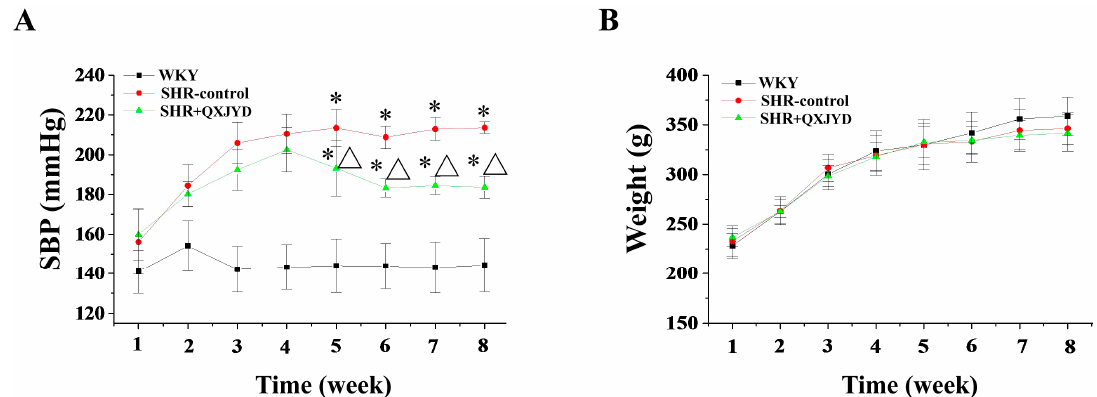
Figure 2. Effect of QXJYD treatment on blood pressure. ( A ) Systolic blood pressure (SBP); and ( B ) body weight were measured in spontaneously hypertensive rats (SHR-control, SHR + QXJYD) and Wistar Kyoto (WKY) rats ( n = 10). All values were represented as mean ± SD. * p < 0.05, compared to WKY group; Δ p < 0.05, compared to SHR-control group.